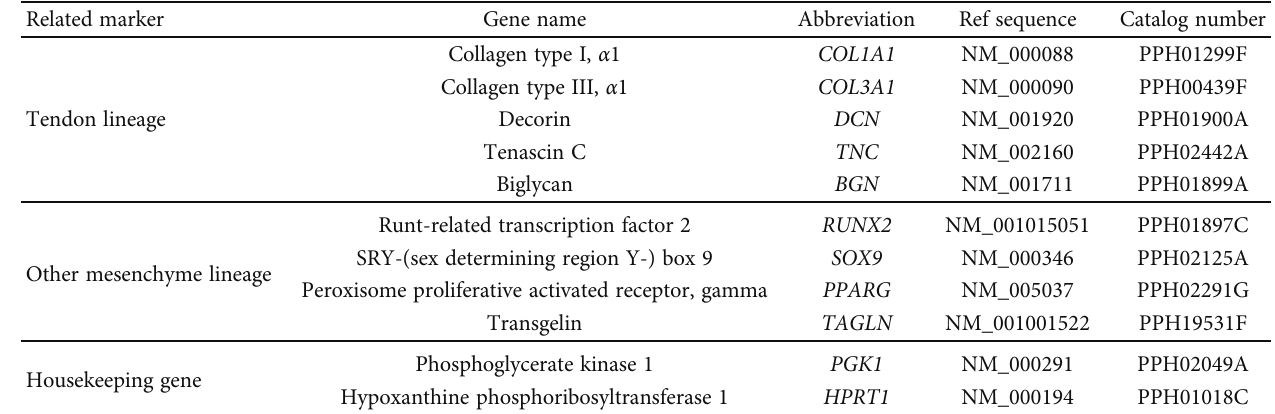
Table 1: The genes of interest were determined in this